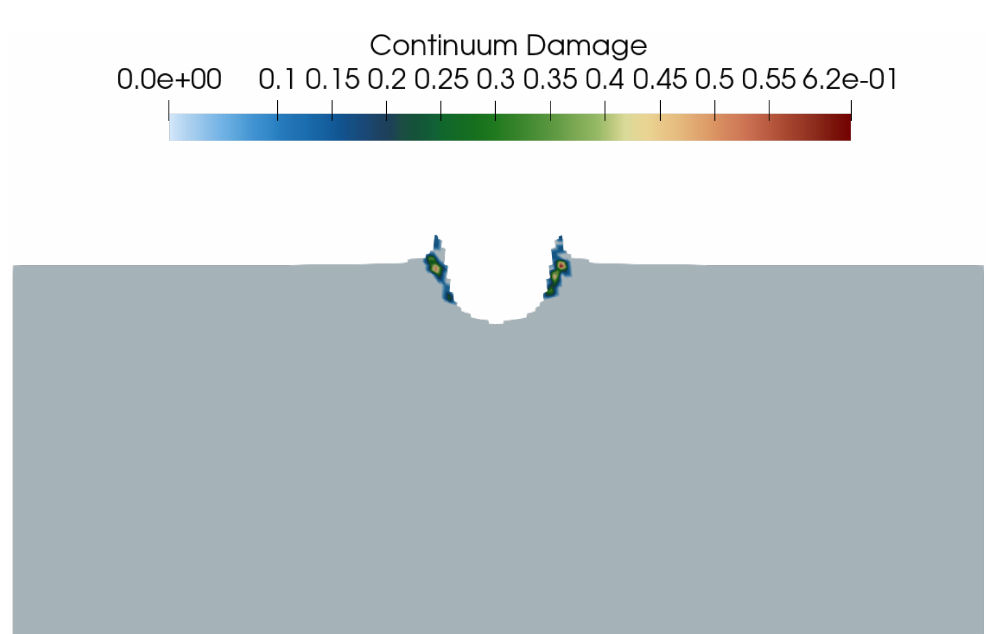
Figure A1. FLAG simulation of 5 × 10 3 m/s Al-Al (Al-6061) normal impact, 1 s after impact, colored by damage.